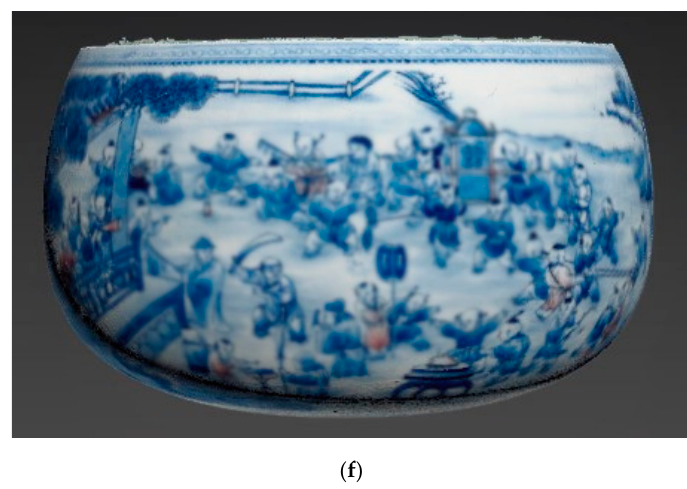
Figure 10. Models before and after evaluation. ( a ) Porcelain cup model after radiation quality selection; ( b ) porcelain cup model with radiation quality problems; ( c ) porcelain bowl ① model after radiation quality selection; ( d ) porcelain bowl ① model with radiation quality problems; ( e ) porcelain bowl ② model after radiation quality selection; ( f ) porcelain bowl ② model with radiation quality problems.